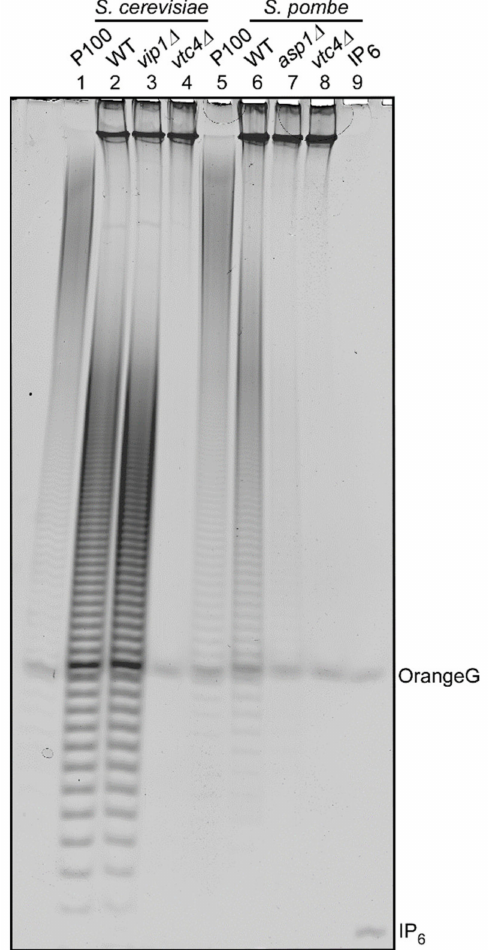
Figure 2. Synthesis of polyP in S. pombe depends on Asp1 function. Phenol-extracted PolyP from exponentially growing yeast cultures and equal amounts of RNA (20 µ g) were resolved on 30% PAGE and visualized by toluidine staining. The extracts of the following strains were analyzed: (from left to right) S. cerevisiae wild-type (WT), vip1 ∆ , and vtc4 ∆ and S. pombe wild-type (WT), asp1 ∆ , and vtc4 ∆ . The figure shows a representative analysis from 3 independent experiments with virtually identical